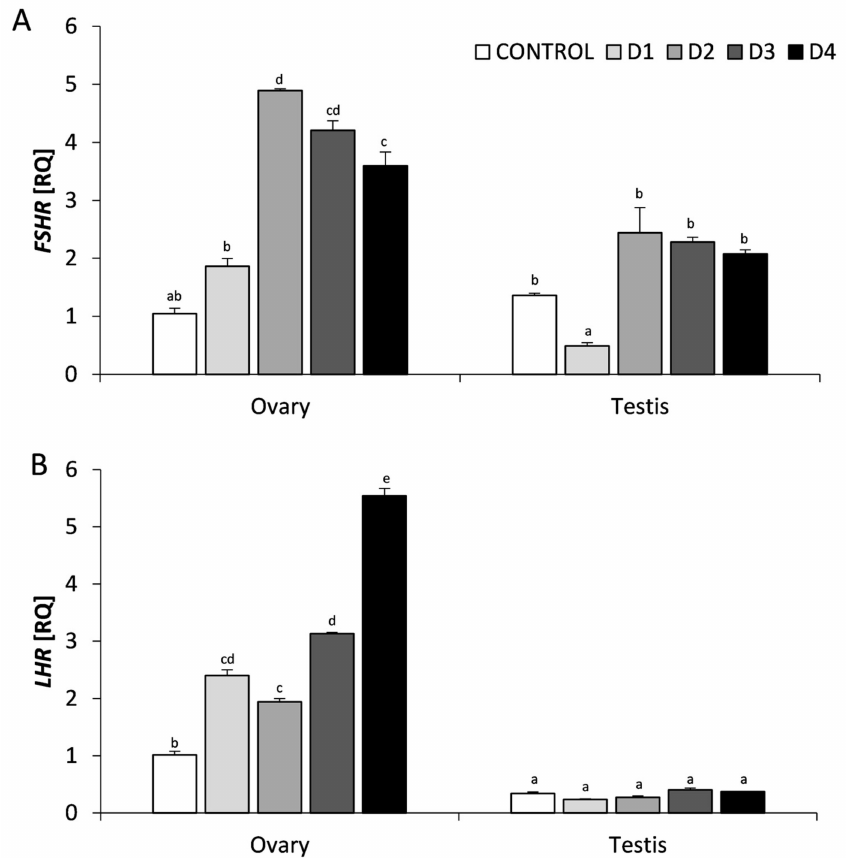
Figure 1. The mRNA expression of genes encoding gonadotropin receptors: follicle stimulating hormone receptor ( FSHR ) ( A ) and luteinizing hormone receptor ( LHR ) ( B ), in the ovary and testes of chicken embryos at the 14th day of embryogenesis, following an in vitro treatment with increasing doses of sodium fluoride (NaF). Each value represents the mean ± SEM from n = 6 (six embryonic gonads). Data of gene expression represent the mean of relative quantity (RQ), standardized to control expression in the ovary (RQ = 1). Statistical differences ( p < 0.05) are marked by